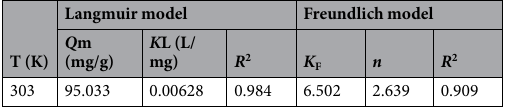
Table 1. Langmuir and Freundlich isotherm parameters of DMF molecules onto PGO.